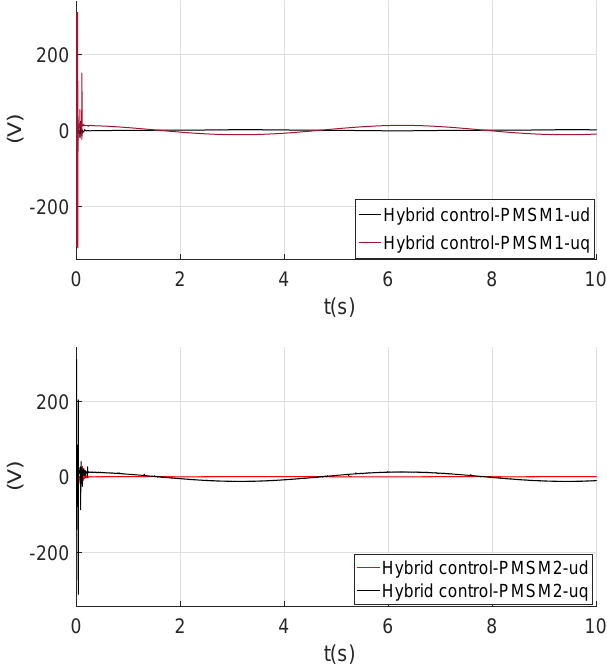
Figure 8. Curve with control voltage of each joint